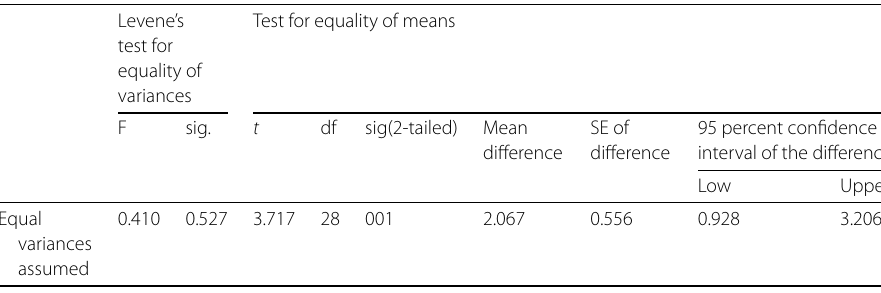
SE of 95 percent confidence difference difference interval of the difference Low Upper